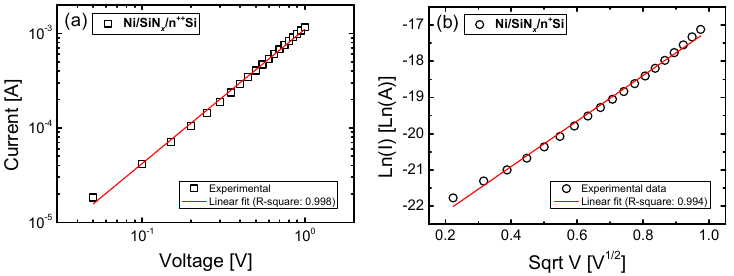
Figure 9. Experimental data and fitting results of the I-V curve in the LRS on ( a ) a log-log scale for Ni/SiN x /n ++ Si and ( b ) for ln(I) as a function of sqrt(V) for Ni/SiN x /n + Si device.